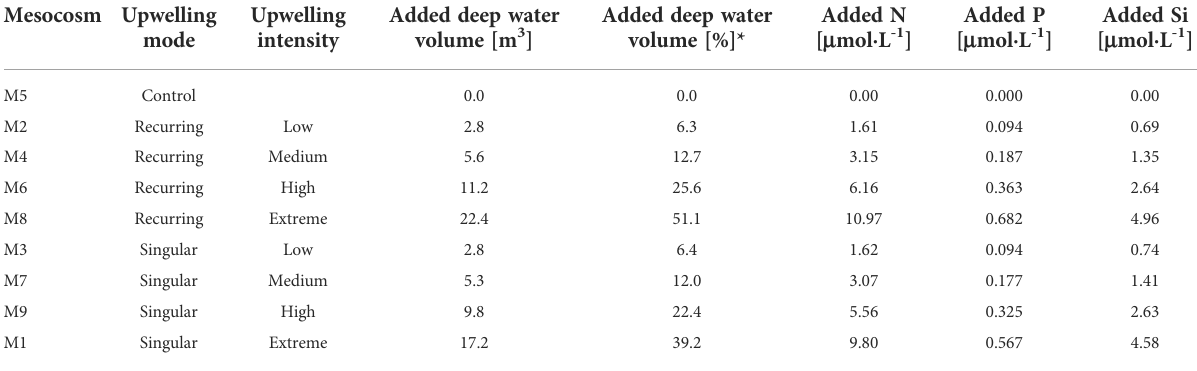
TABLE 1 Information of the treatments applied to each